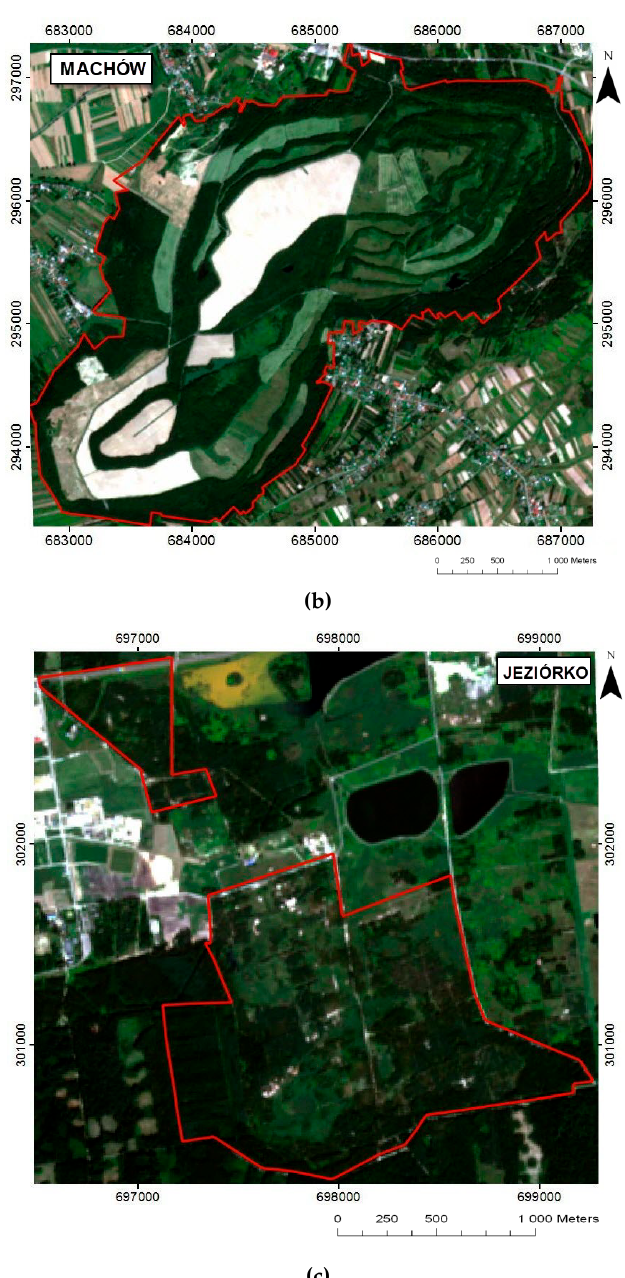
Figure 1. The study areas: ( a ) overview map of Poland (aerial orthophoto 2012, coordinates system PL-1992), ( b ) Machów, and ( c ) Jeziórko − using Sentinel-2 (European Space Agency; ESA) red green blue (RGB) color composition (red line boundaries of study areas).